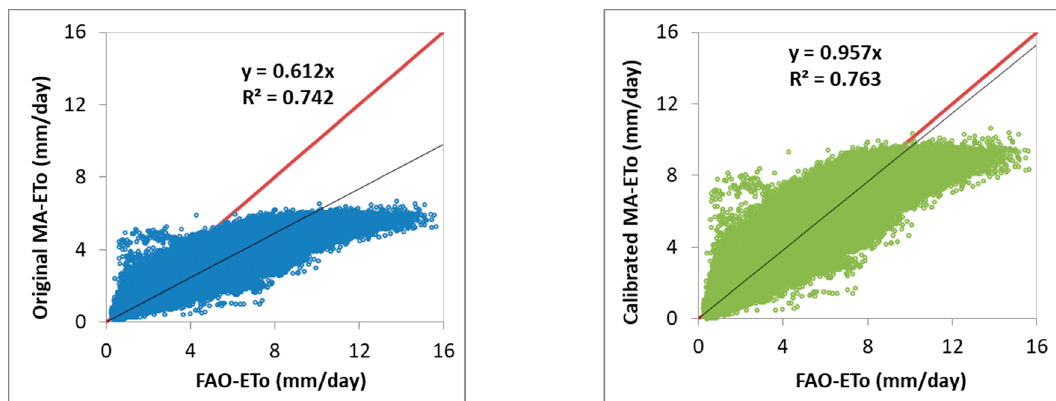
Figure 4. Relationship between estimated ET o by the selected empirical methods and FAO-PM using high-resolution PRISM weather data.